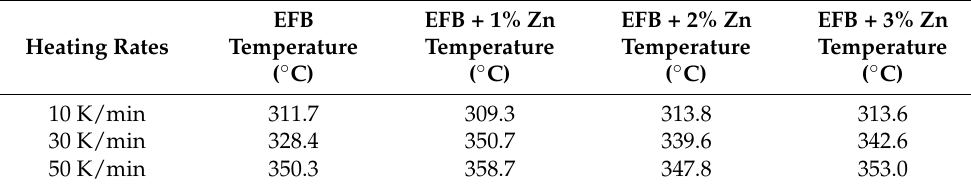
Table 3. EFB samples temperature at 50% conversion.